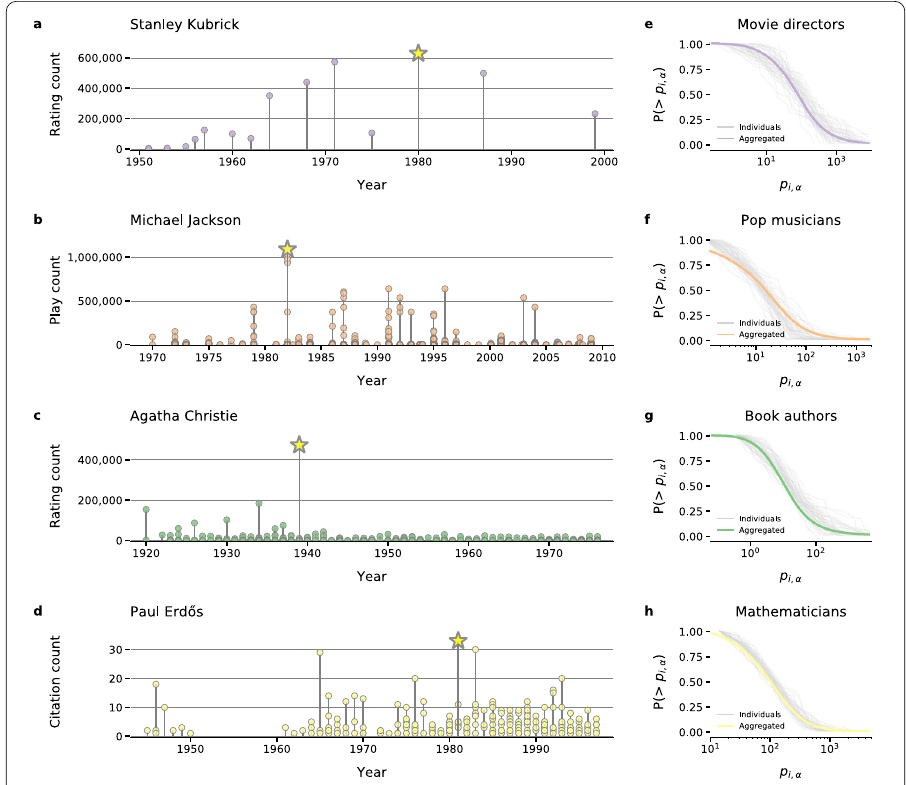
Figure 1 Career examples and rescaled impact distributions in four creative domains. ( a ) The career trajectory of Stanley Kubrick. On the horizontal axis, we show the release year of his movies, while on the vertical axis we show the impact of each movie, captured by the number of ratings received from IMDb users. ( b ) The career of Michael Jackson. We show the release year of his songs and the song impact captured by the total play count on the music provider LastFM. ( c ) The career of Agatha Christie. We report her books’ publication dates and the book impact, captured by the number of ratings they received on